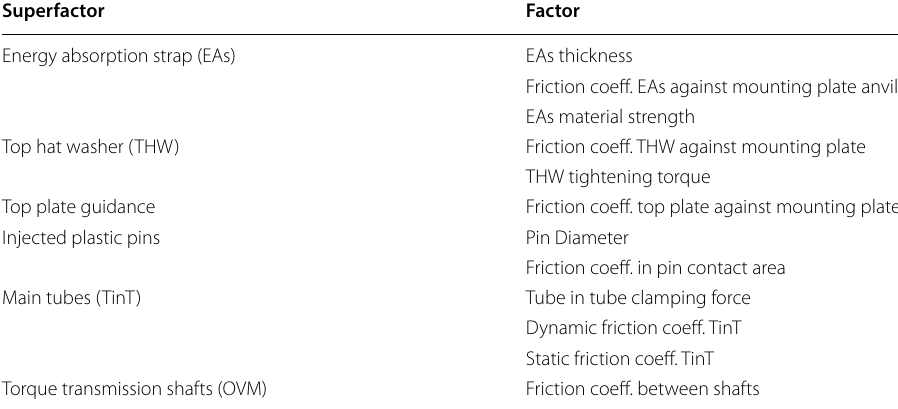
Table 1 Superfactors and